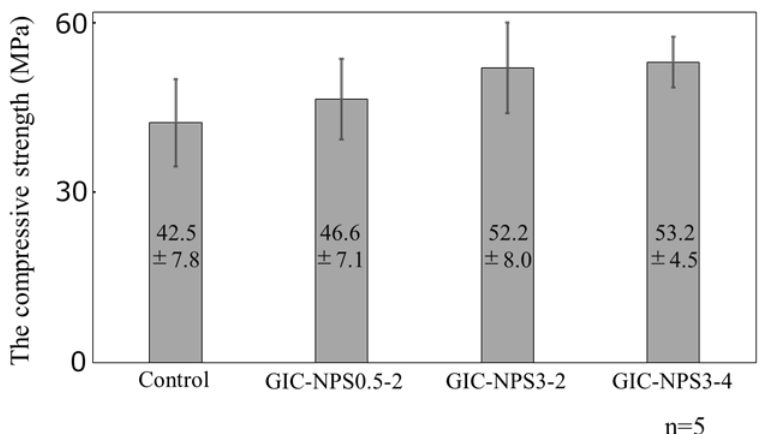
Figure 6. The compressive strength of